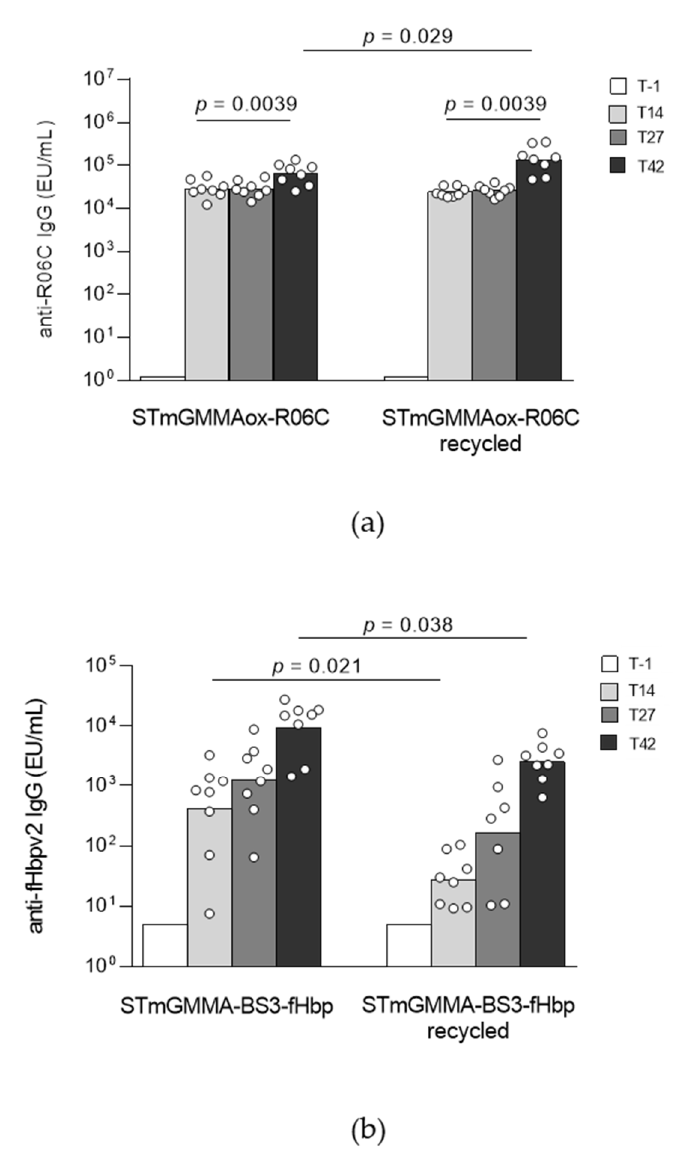
Figure 8. GMMA conjugated to additional heterologous antigens (R06C and fHbp v2) and possibility of recycling the unconjugated protein verified: immunogenicity of R06C conjugates (reductive amination) ( a ) and fHbp v2 conjugates (BS3) ( b ) in mice. CD1 mice were immunized subcutaneously at day 0 and 28 with 4 μ g R06C/dose ( a ), or 2.5 μ g total protein/dose ( b ). All constructs were formulated with 0.7 mg/mL Alhydrogel. Sera were analyzed at days − 1, 14, 27 and 42 by ELISA using as coating antigens R06C ( a ) or fHbp v2 ( b ). Summary graphs of anti ‐ antigen specific IgG geometric mean units (bars) and individual antibody levels (dots) are reported.